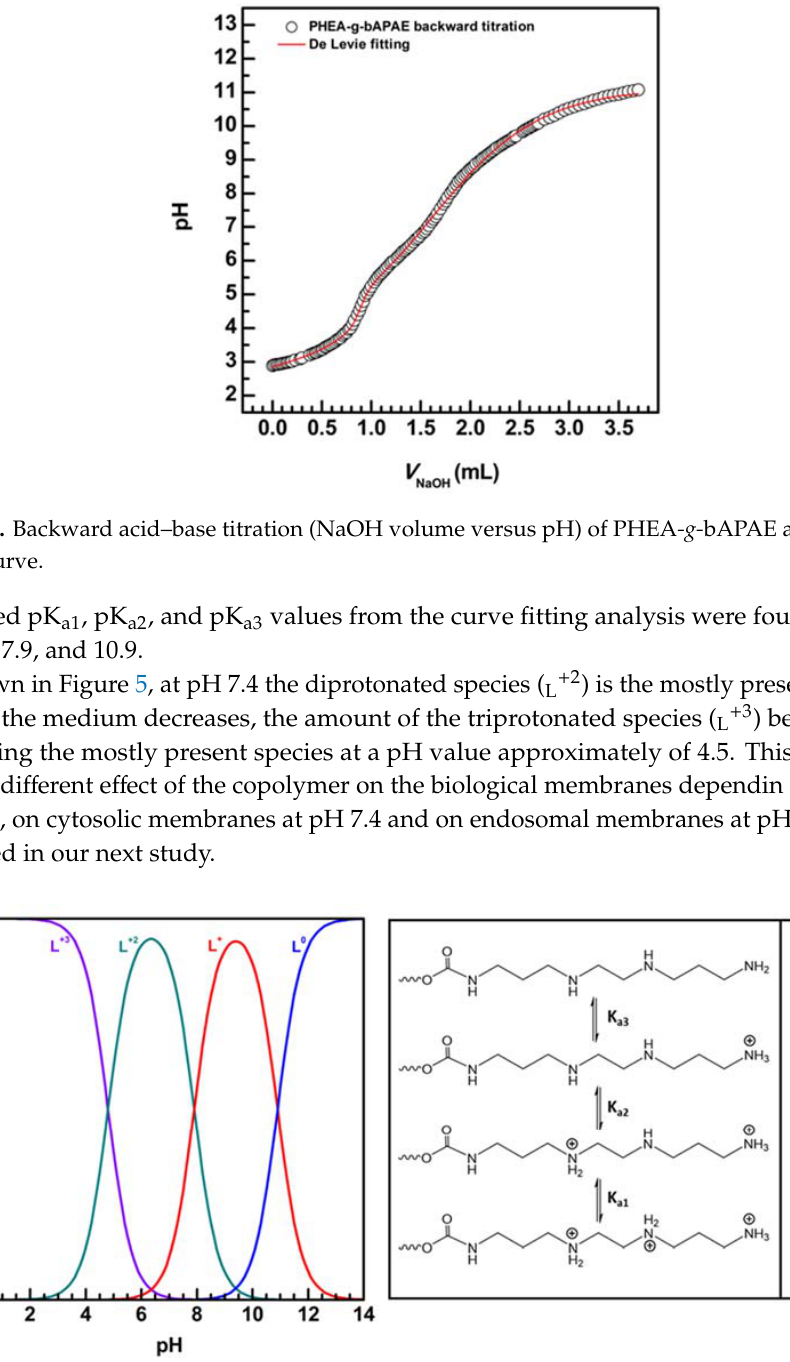
Figure 5. Speciation curves obtained for Plot α versus pH for each α of PHEA ‐ bAPAE PHEA ‐ g ‐ bAPAE and protonation state of PHEA ‐ bAPAE PHEA ‐ g ‐ bAPAE at different pH values.